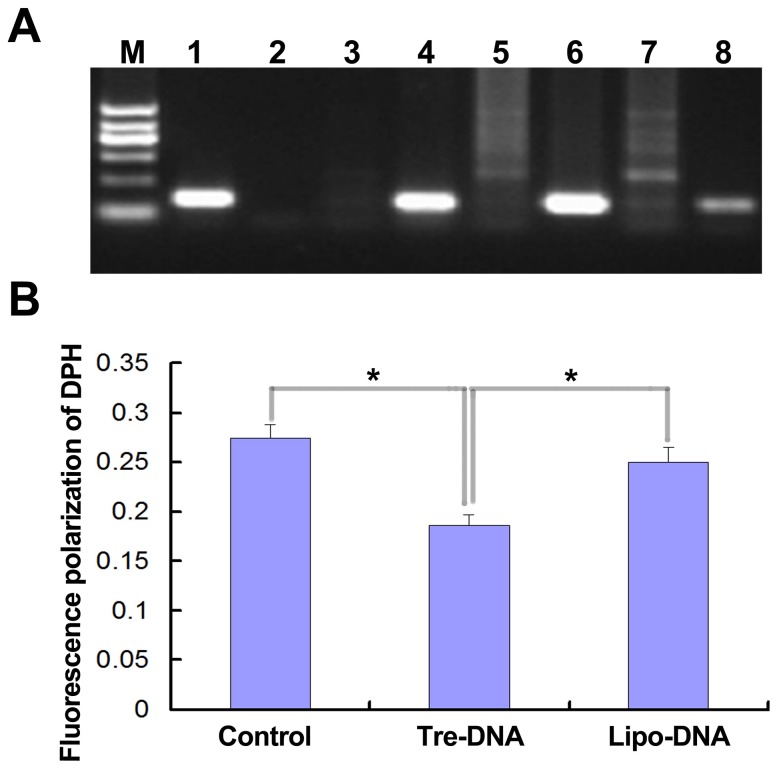
Internalization of plasmid DNA into sperm and analysis of sperm membrane fluidity at 3rd day after the complexes injected into mouse epididymal efferent tubule.A) Detection of internalization of plasmid DNA into sperm by PCR. M: molecular mark; 1st lane: plasmid DNA; 2nd lane: the sperm samples from wildtype mouse; 3rd, 5th and 7th lane: the sperm samples from mouse injected Lipo-DNA; 4th, 6th, and 8th lane: the sperm samples from mouse injected Tre-DNA. B) Membrane futility of sperm was measured by fluorescence polarization of DPH according to Companyo, M et al [32]. The plasma membrane fluidity increasing, while the DPH fluorescence polarization decreasing. Control: sperm from common mouse; Tre-DNA: sperm from mouse injected complex of trehalose and plasmid DNA; Lipo-DNA: sperm from mouse injected complex of lipofectamine 2000 and plasmid DNA. * indicated significant differences (p<0.05,n = 8).